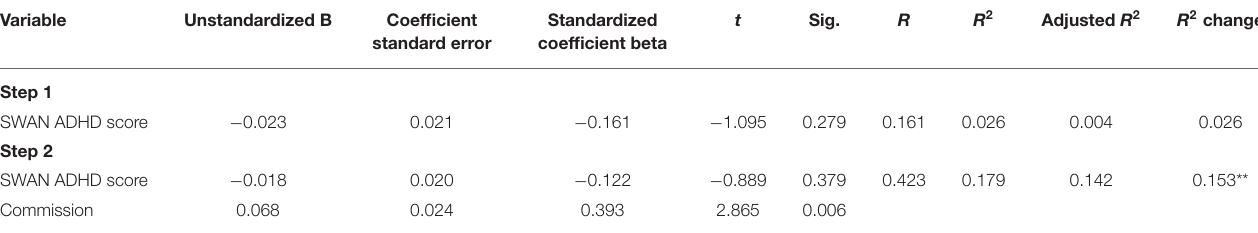
TABLE 10 | Regression model of the CCPT measures as the predictors of the CBCL withdrawn subscale score in the control group. Variable